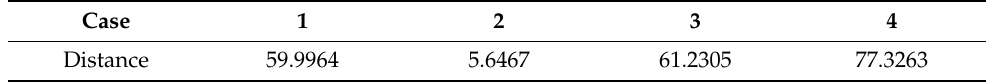
each case are shown in Table 4. Table 4. Max-sliced Wasserstein distance of four